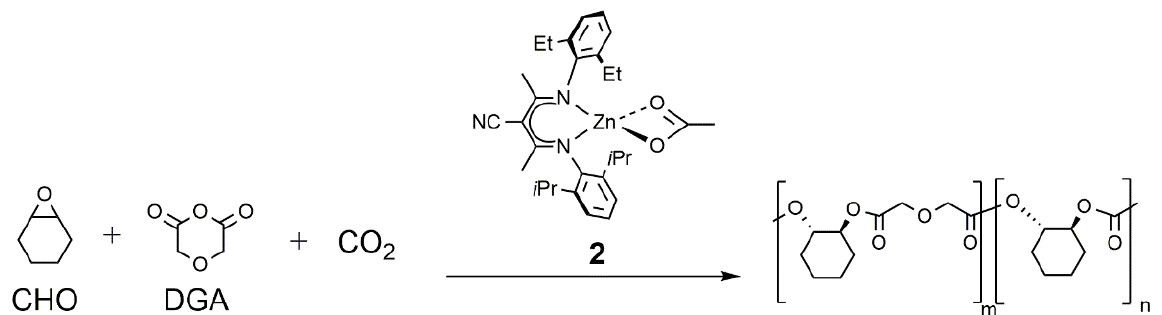
Figure 1. The structure of CO 2 /PO/MA terpolymer obtained by Liu using complex 1 [21]. Later on, in 2008, the development of an efficient homogeneous catalytic system by Coates based on β -diiminate (bdi) zinc complex 2 (Figure 2) allowed the synthesis of a poly(ester- block -carbonate) by the terpolymerization ( p CO 2 = 0.3–5.4 MPa, T = 50 °C, t = 0.2–3 h) of cyclohexeneoxide (CHO) with diglycolic anhydride (DGA) and CO 2 [22].